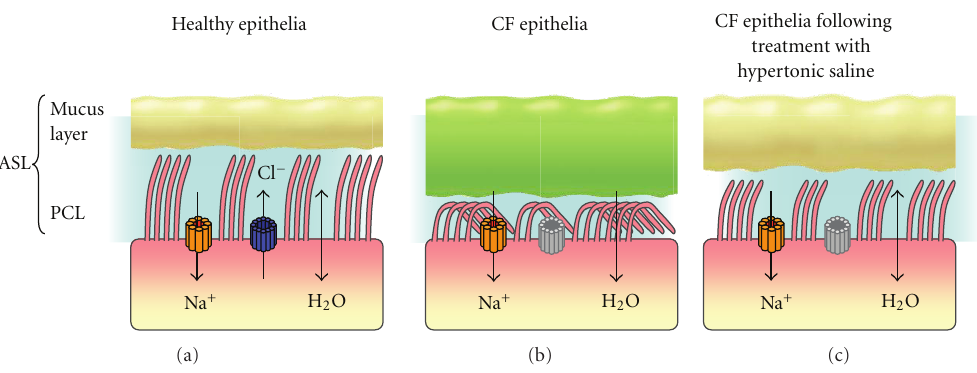
Figure 3: E ff ect of hypertonic saline on the airway surface liquid (ASL) in CF. (a) In healthy airway epithelia, CFTR is intact and plays a vital role in regulating hydration of the ASL that consists of the periciliary layer (PCL) and the mucus layer. (b) Due to defective CFTR in CF, Cl (cid:21) secretion is impaired and Na + absorption through ENaC is upregulated resulting in dehydration of the ASL with thick mucus accumulating and causing the PCL to collapse. (c) Treatment with hypertonic saline is proposed to reduce mucus viscosity and aids its clearance by various mechanisms. The high salt concentration encourages osmosis of water into the ASL and thereby rehydrates the mucus and partially restores the PCL allowing for easier clearance of mucus. Additionally, the high ionic strength weakens ionic bonds between negatively charged GAGs and thus reduces the viscosity of the